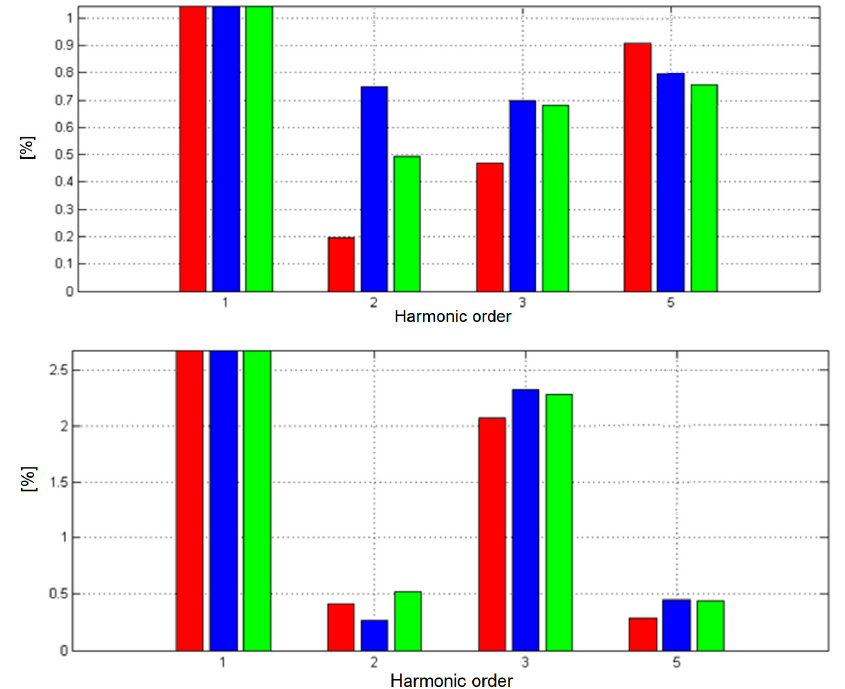
Figure 24. Harmonic spectra of three-phase currents ( top ) and voltages ( bottom )—quantities acquired at the terminals of the main generator for the active power of 171 MW.